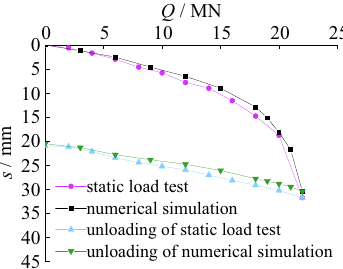
Figure 15. Comparison of load-settlement curves.